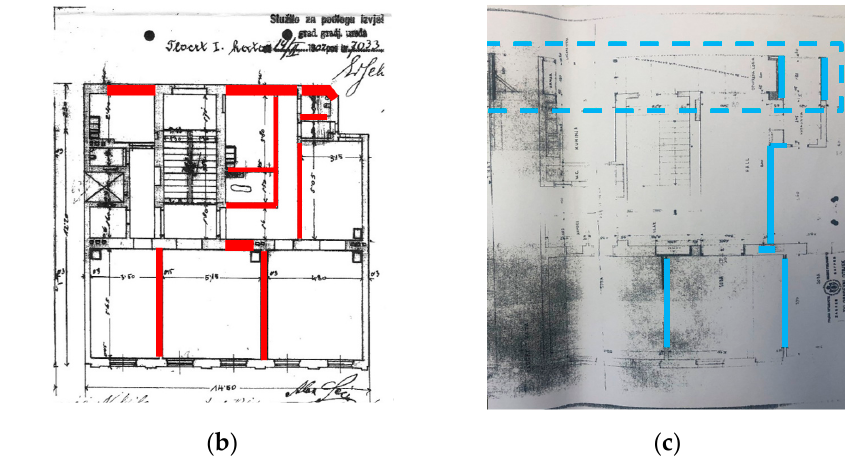
Figure 4. Investigated buildings Ribnjak 44: ( a ) original drawings from the State Archives in Zagreb; ( b ) reconstruction-demolished walls shown in red color State Archives in Zagreb; (c) construction of new walls and a lodge [32]. Reproduced with permission from State Archives in Zagreb, 2022.